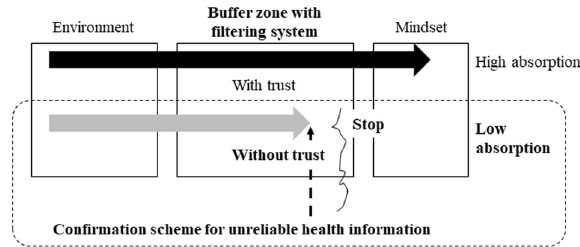
Fig. 1 Information absorption process.